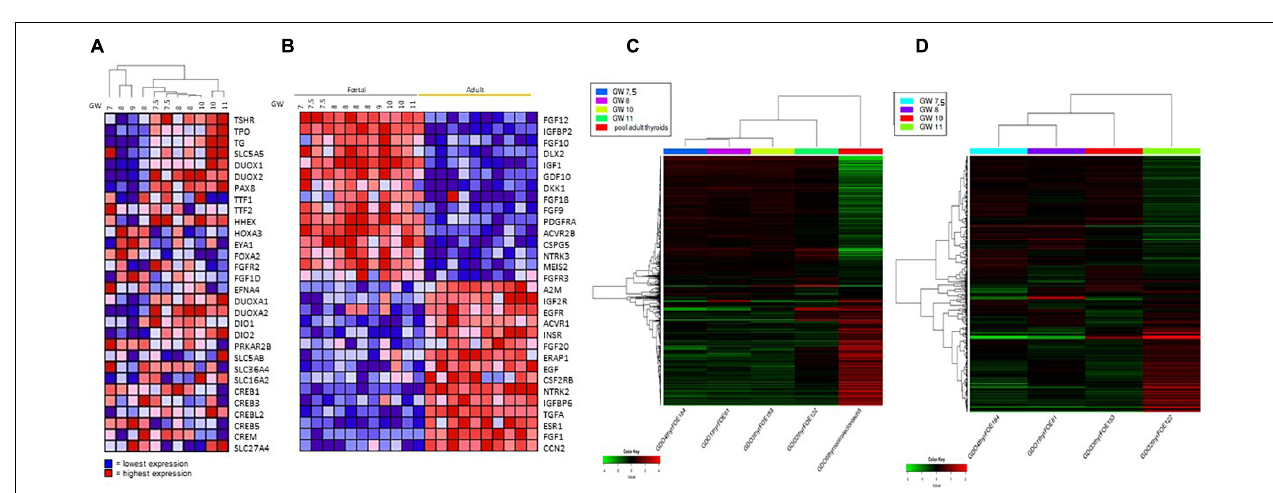
FIGURE 4 | (A) Hierarchical clustering of mRNA expression levels of thyroid function proteins in fetus samples. Hierarchical clustering and heat map of expression ratios of genes involved in thyroid function in fetal thyroids versus the pool of normal adult thyroid samples (CLONTECH). For each gene (row), the expression ratio ranges between lowest in dark blue to highest in dark red. (B) Heat Map: expression of growth factors and receptor signaling proteins in fetal and adults thyroids. For each gene (row), the expression ratio ranges between lowest in dark blue to highest in dark red. GW, gestational week. (C) Hierarchical clustering of the RNAseq expression data of the 2000 most variable genes in four fetus thyroid samples ranging from GW 7.5 to GW 11, and in one adult thyroid sample. Hierarchical clustering and heat map of expression (in CPM -Counts Per Million-) of the 2000 most variable genes in fetal thyroids (GW: 7.5, 8, 10, 11) versus the pool of normal adult thyroid samples (CLONTECH). For each gene (row), the expression ratio ranges between lowest in dark green to highest in dark red. (D) Hierarchical clustering of the RNAseq expression data of the 2000 most variable genes in four fetus thyroid samples ranging from GW 7.5 to GW 11. Hierarchical clustering and heat map of expression (in CPM -Counts Per Million-) of the 2000 most variable genes in fetal thyroids (GW: 7.5, 8, 10, 11). For each gene the expression ratio ranges between lowest in dark green to highest in dark